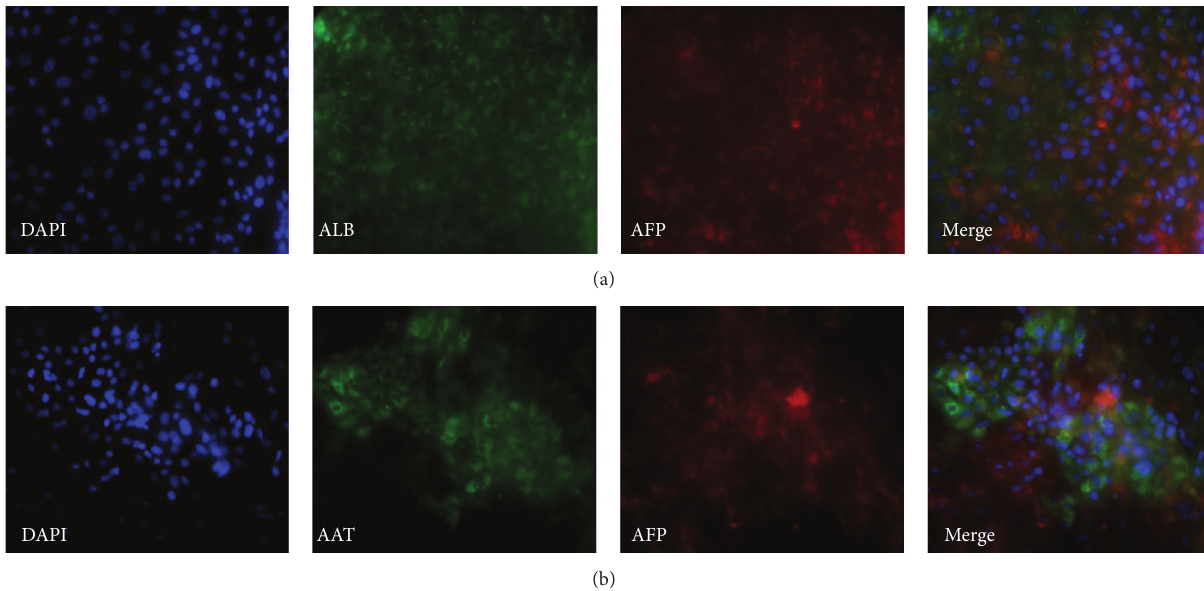
Figure 11: Representative micrographs illustrating the expression of markers at day 29 of the hepatic differentiation of the cell line ChiPSC6b. Magnification: 20x. Panel (a) shows stainings for ALB and AFP. Panel (b) shows stainings for AAT and AFP.